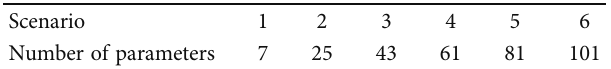
Table 1: Number of parameters ( 1 + sr ) for the di ff erent